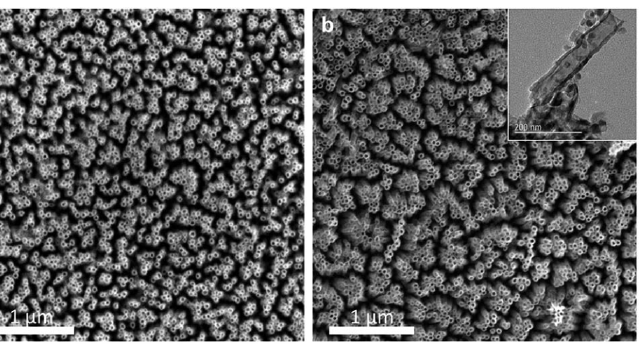
Figure 6. SEM images of TiO 2 nanotube film ( a ) before and ( b ) after proton irradiation with inset TEM image, showing retained structural morphology. Reproduced with permission from ref. [43].